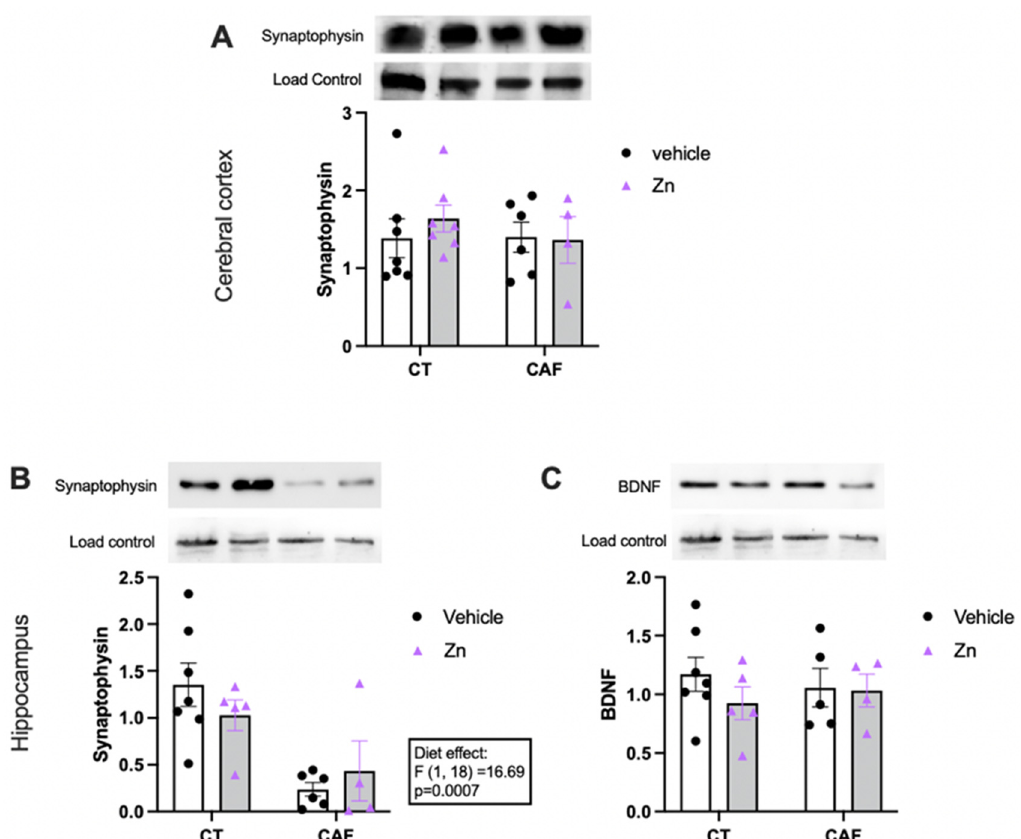
Figure 5. Protein expression of synaptophysin and brain-derived neurotrophic factor (BDNF) in the cerebral cortex ( A ) and hippocampus ( B , C ) of control (CT) and cafeteria diet (CAF)-fed rats. Repre- sentative bands of each group are shown on the top of the graphs. β -actin or nonspecific bands were used as a loading control. The text box indicates significant differences shown by two-way ANOVA regarding the effects of diet (CT and CT + Zn vs. CAF and CAF + Zn). n = 4–7 animals/group.